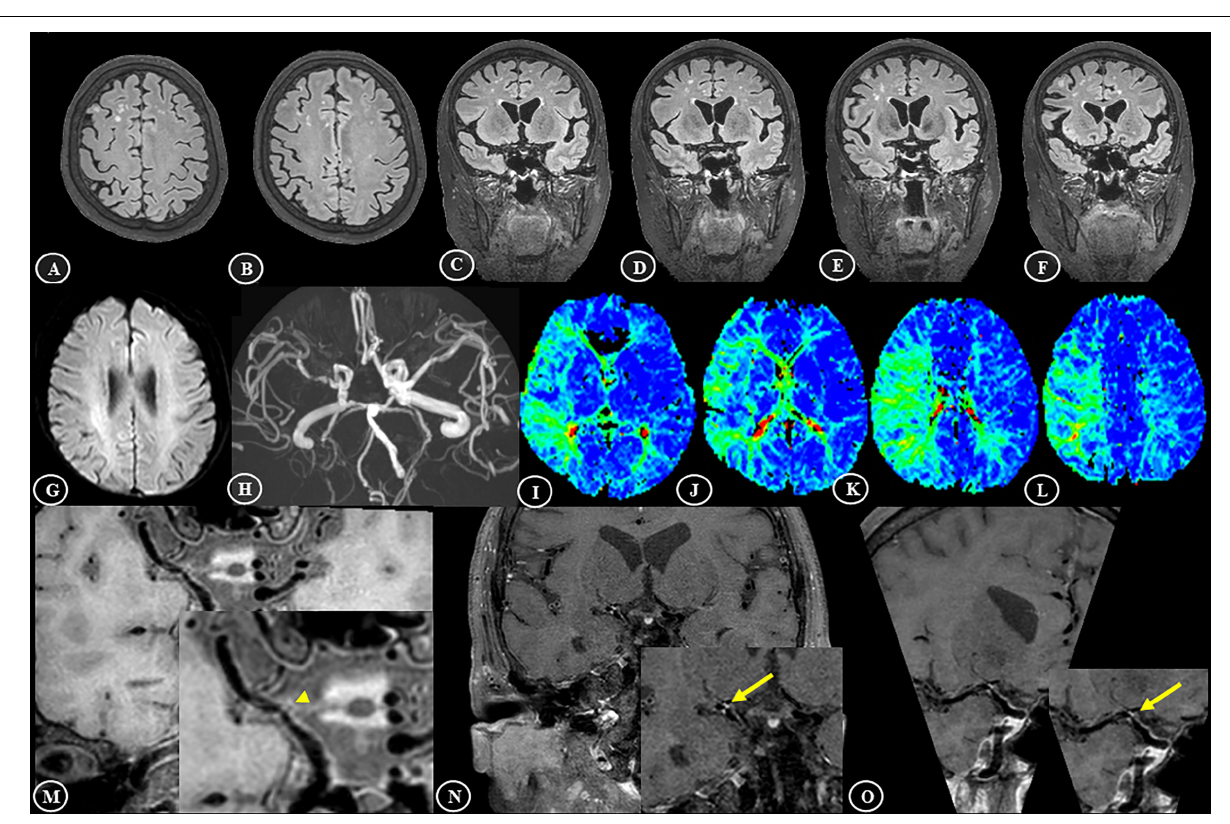
FIGURE 4 | Representative brain MR findings of a 74-year-old female patient with white matter hyperintensities and intracranial atherosclerosis. The patient was admitted with dizziness for 1 month. (A–F) On the 3D-FLAIR images, asymmetrically distributed white matter hyperintensities, mainly in the right deep white matter area, are shown. (G) Diffusion-weighted imaging (DWI) showed a normal appearance. (H) 3D-TOF MRA showed significant stenosis in the M1 segment of right middle cerebral artery (MCA). (I–L) According to the Alberta Stroke Program Early CT score (ASPECTS), the TTP maps showed a large area of hypoperfusion, including M1–6 and the insular ribbon, and the TTP-ASPECTS was 3. (M–O) T 1 -VISTA image showed an isointense plaque in the right MCA (arrowhead), and the contrast-enhanced T 1 -VISTA image showed strong enhancement of the plaque (grade 2)